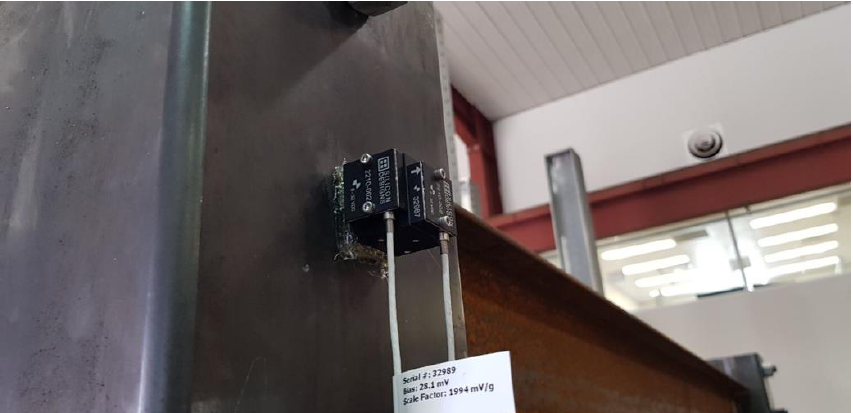
Figure 6. Accelerometers mounted at the top of module’s column.